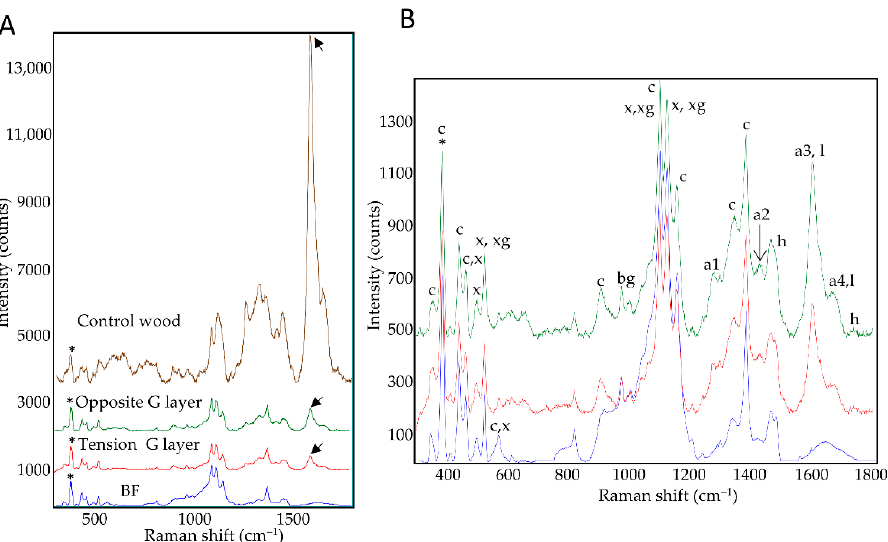
Figure 2. Average Raman spectra. A: xylem G ‐ layers (tension, opposite) compared to control bast fiber G ‐ layers or control wood SCW. B: zoom on average spectra from xylem and BF G ‐ layers. tension side (red), opposite side (green), bast fibers (blue) and control wood (brown). Annotation: a1–4: aromatic compounds and monolignols; bg: beta glucan; c: cellulose; h: hemicelluloses; l: lignin; x: xylan; xg: xyloglucan. For average spectra, normalization was performed on the 380 cm –1 peak assigned to cellulose (*). Aromatics/lignin (black arrow). For peak assignation, see Table S1 for details [22–29]. See also Figure S1 for focus on specific spectral zones (mean centered spectra).